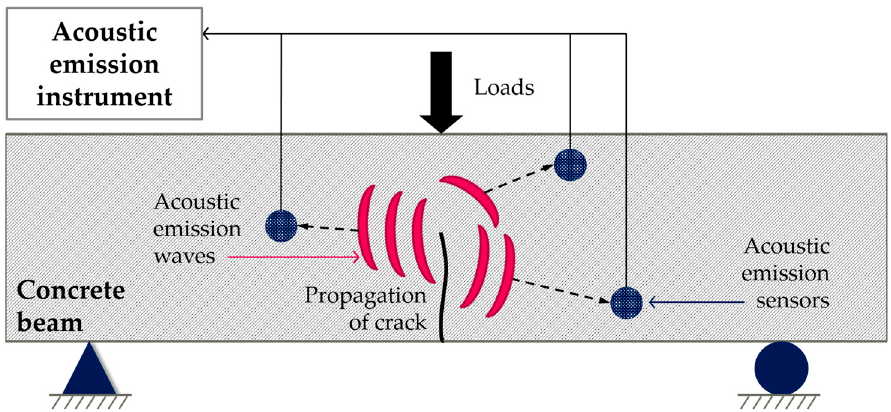
Figure 6. Measurements of acoustic emission (AE) signals for crack propagation.